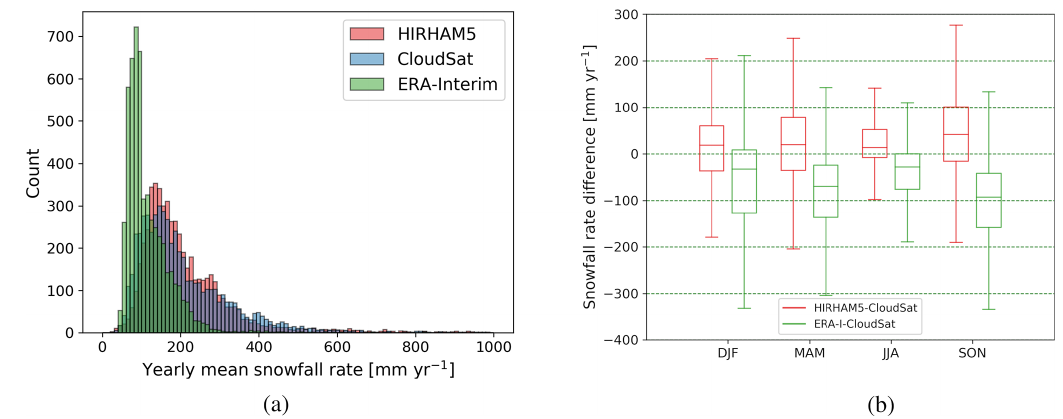
Figure 4. (a) Histogram of yearly mean snowfall rates of HIRHAM5, CloudSat and ERA-Interim and (b) box plot of the difference in yearly snowfall rate between HIRHAM5 and CloudSat (red) and ERA-Interim and CloudSat (green) distributed seasonally. The box extends from the lower to upper quartile values, the line shows the median, and the whiskers show the range of the difference values as the first and third quartiles. The significance of the median difference for both HIRHAM5 and ERA-Interim compared to CloudSat observations is shown to be statistically robust for all seasons performing the Student’s t test with random samples (10% of the total amount) of the observed difference distributions.